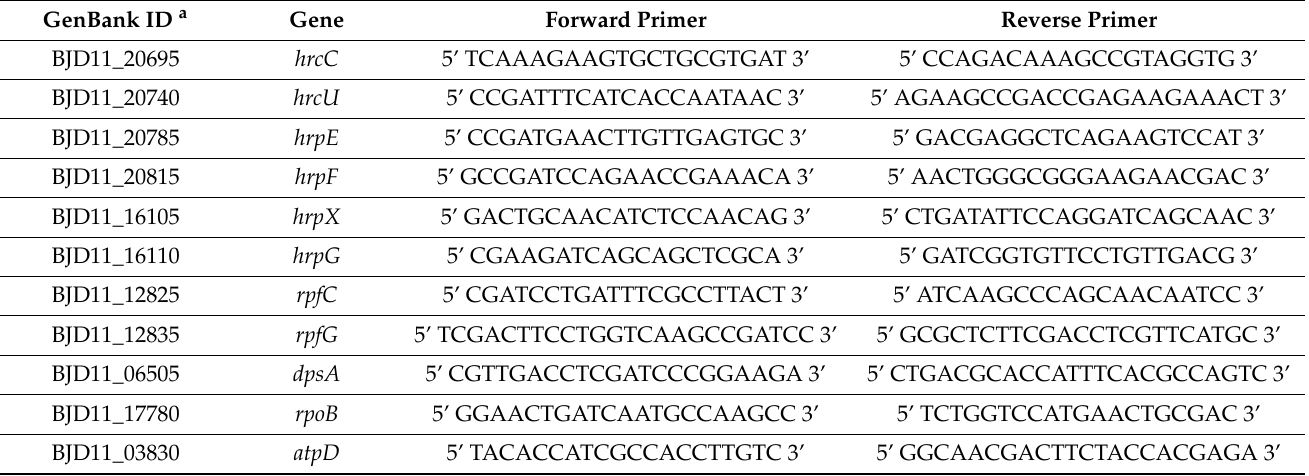
Table 1. Primers used in this study to measure Xanthomonas euvesicatoria gene